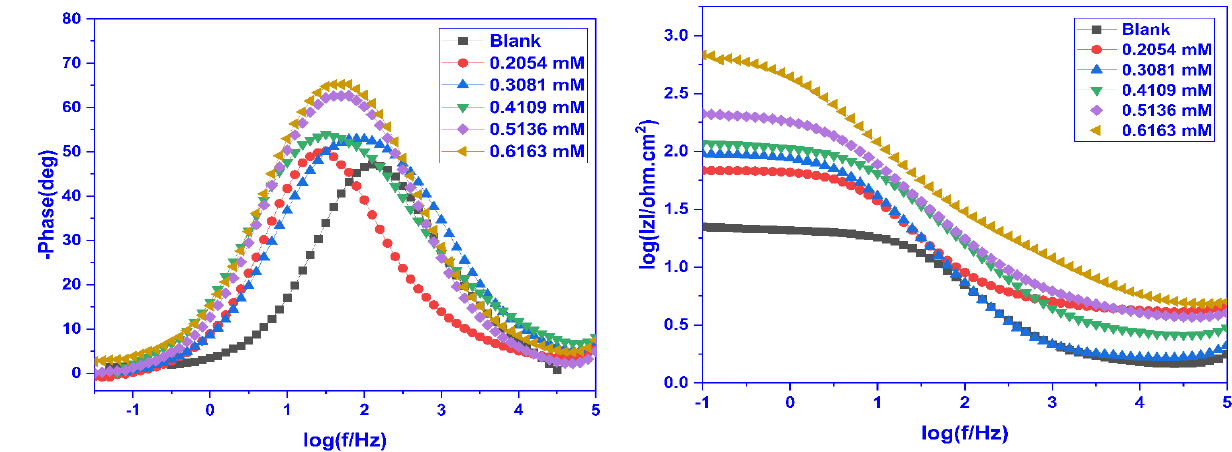
Figure 7. Nyquist plots for blank and different CMEA doses at 30 °C in 1 M HCl for MS ( Left ) and the electrical equivalent circuit employed to analyse the EIS data.